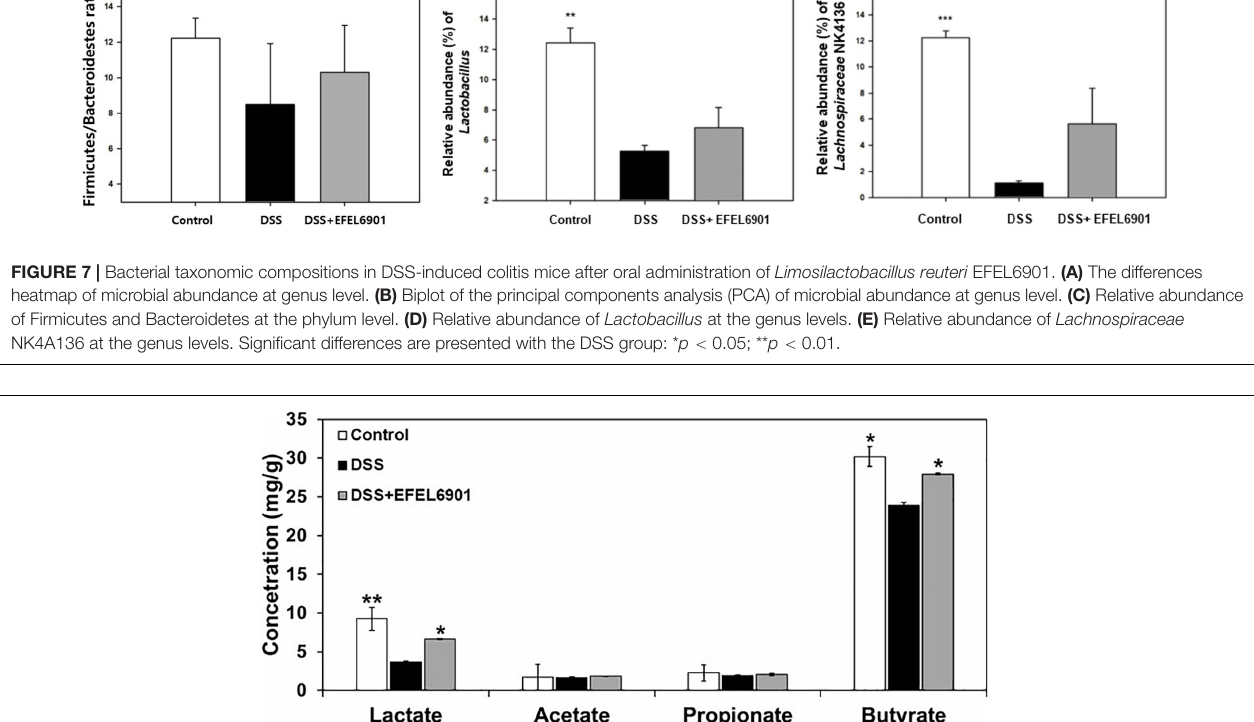
FIGURE 8 | Effects of Limosilactobacillus reuteri EFEL6901 strain on short-chain fatty acids (SCFAs) levels in mouse cecum. Significant differences are presented with the DSS group: * p < 0.05; ** p < 0.01.